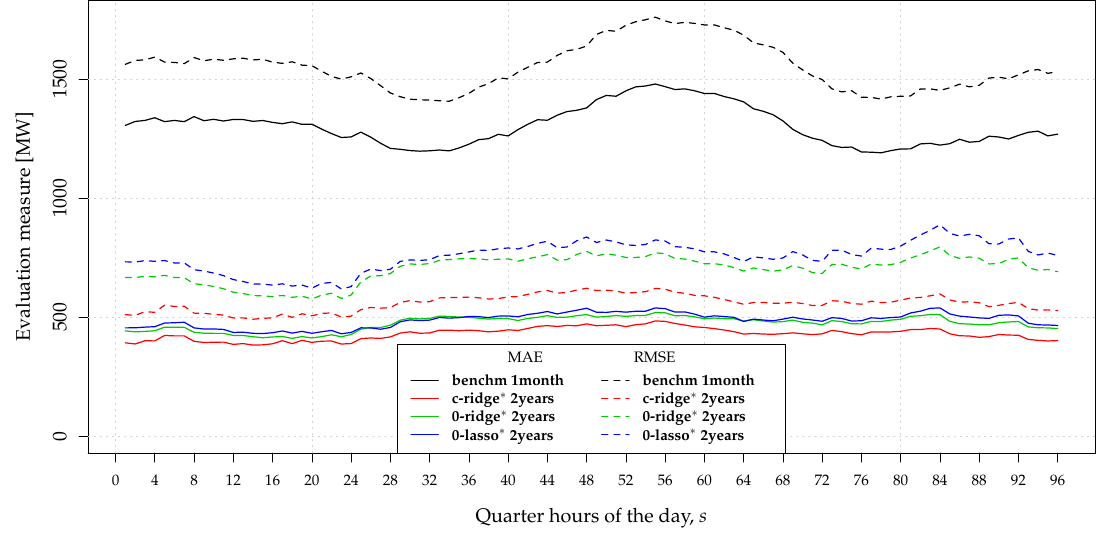
Figure 5. Intraday prediction accuracy in MAE s and RMSE s of selected